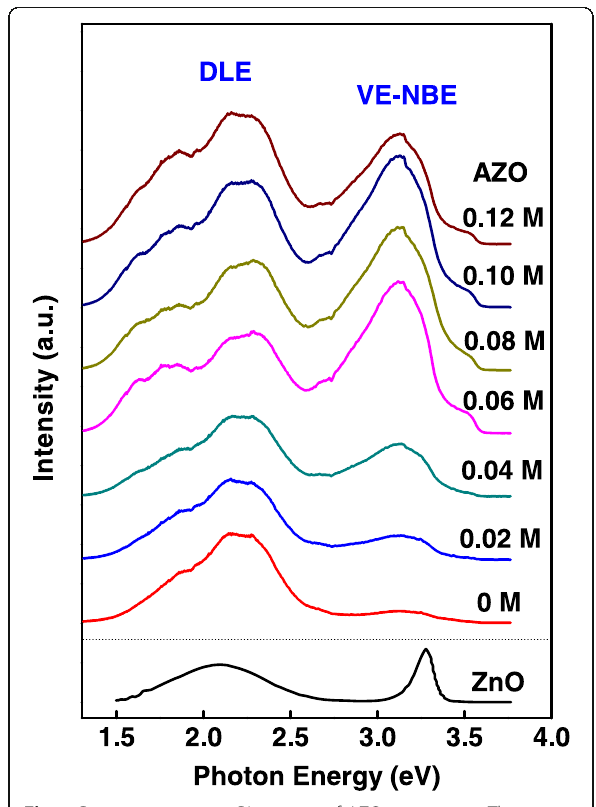
Fig. 5 Room temperature PL spectra of AZO nanospears. The spectra are vertically offset for clarity. The spectrum in the bottom of the figure is the PL spectrum of undoped ZnO rods in [2]